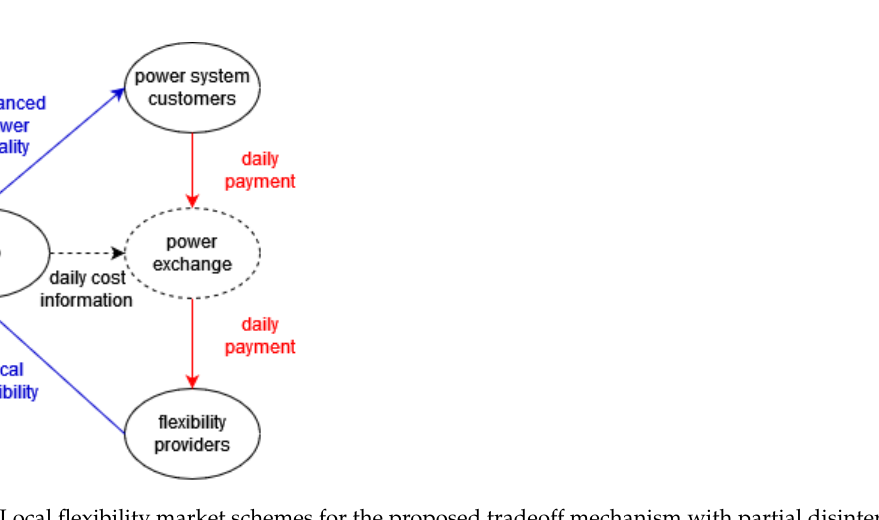
Figure 2. Local flexibility market schemes for the proposed tradeoff mechanism with partial disin- termediation.